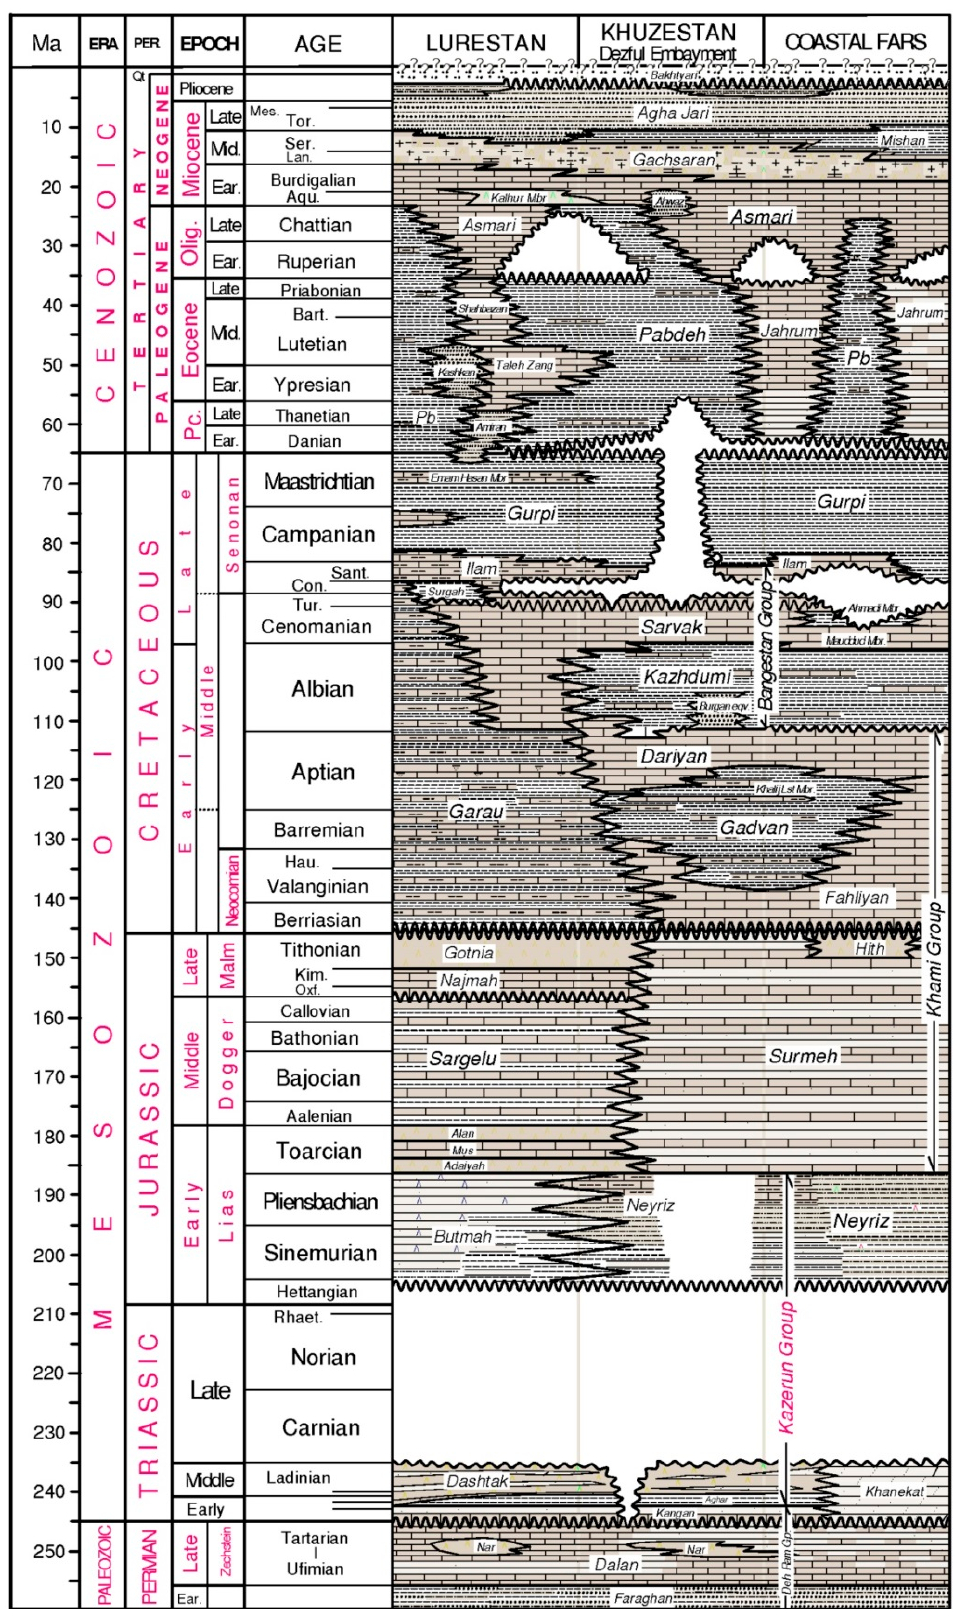
Figure 4. Lithostratigraphic column of the Coastal Fars (Right side of the column where the Sarvak, Jahrum and Asmari formations can be identified) region where the Kuh-e-Mond heavy oil field is located (From [33] after [34]).